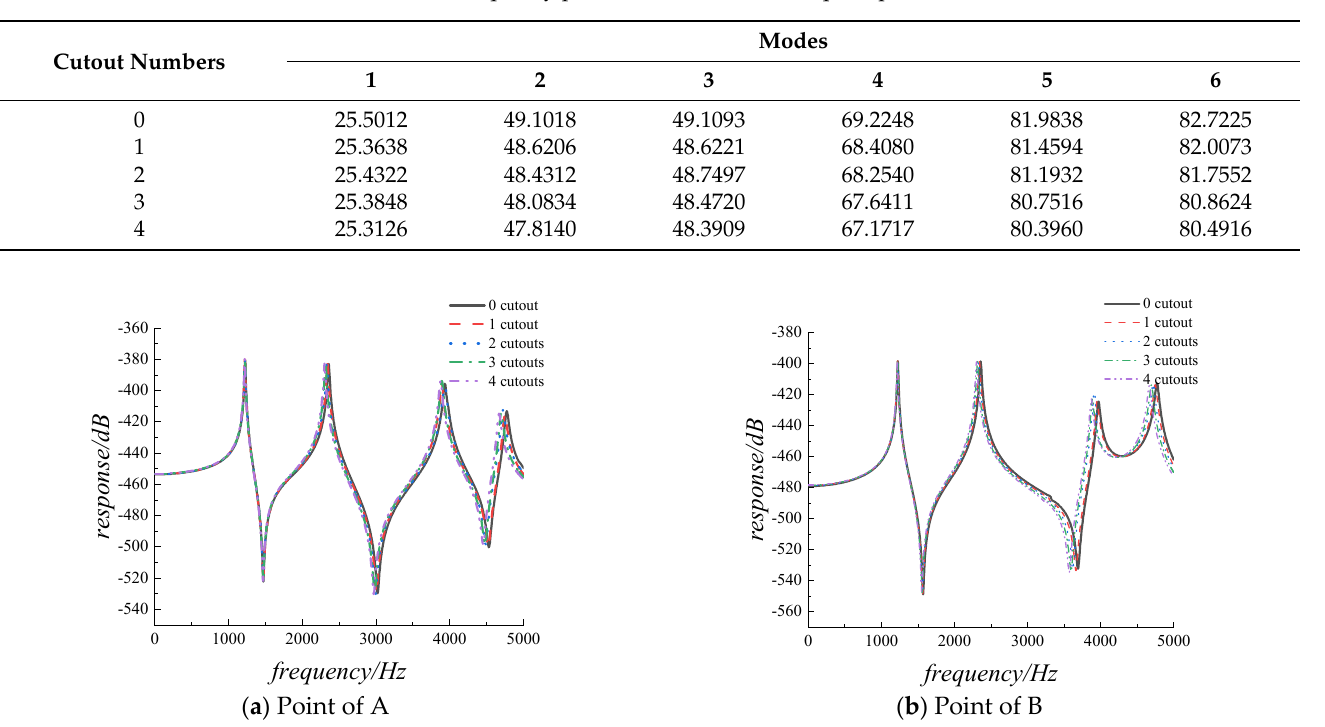
Table 10. The first six non-dimensional frequency parameters of the FGMs square plate with diverse cutout numbers.